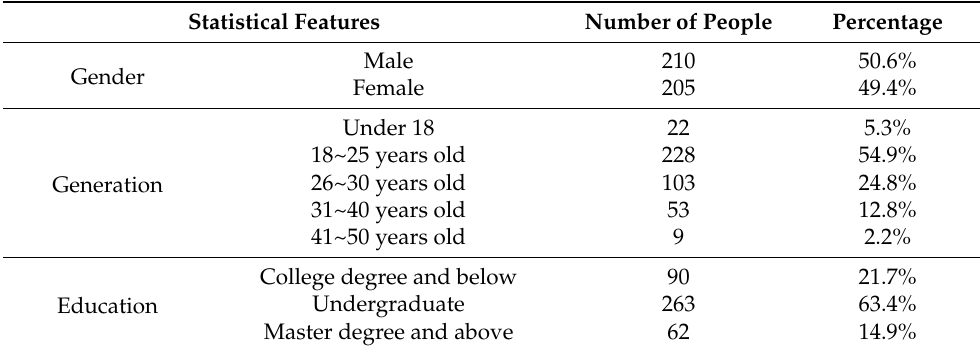
Table A1. Sample statistical